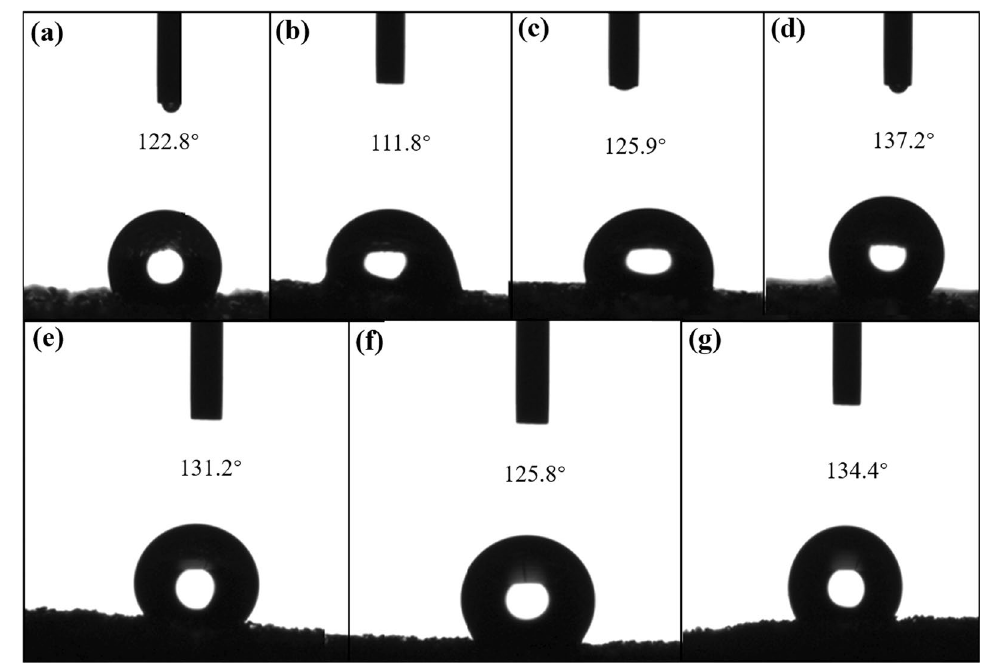
Fig. 3 The WCA of BC/PU foam composites